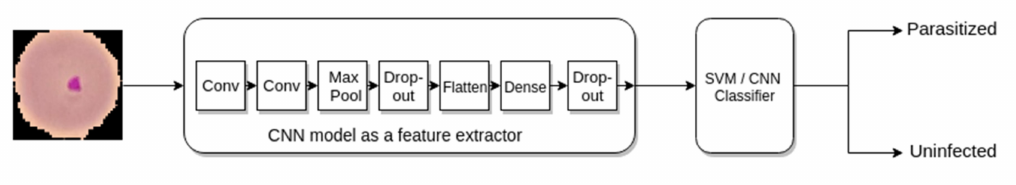
Figure 7. Modified CNN-KNN or CNN-SVM